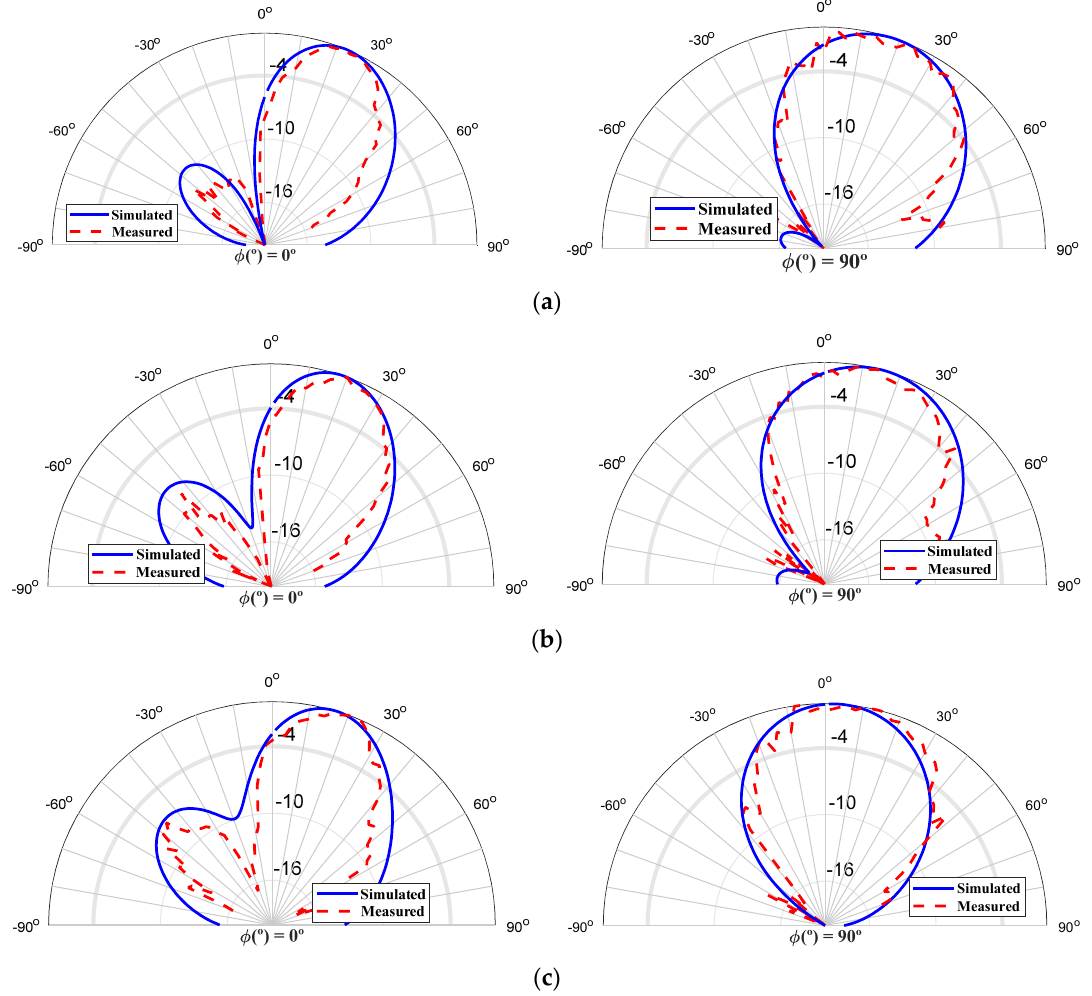
Figure 6. Radiation pattern of the 5-element log-periodic microstrip antenna array in the two main planes ϕ = 0° and ϕ = 90° for different frequencies: ( a ) f = 27 GHz, ( b ) f = 28 GHz, and ( c ) f = 29 GHz.